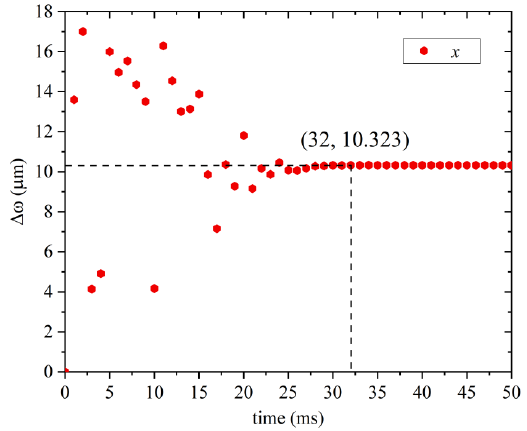
Figure 10. Relationship between diaphragm deformation and response time.